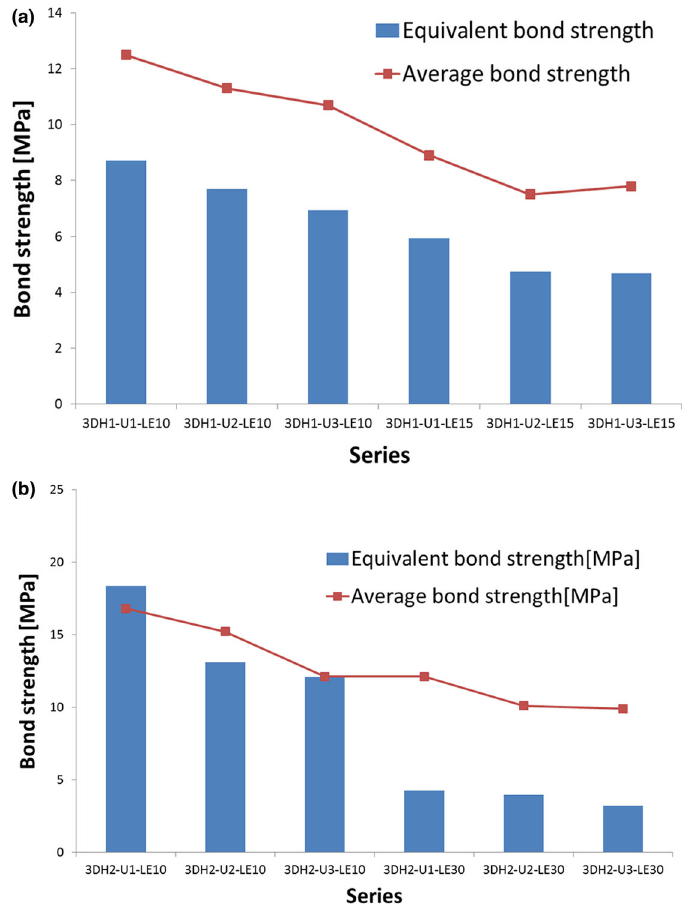
Fig. 8 Effect of W/B ratio on the bond strength of a 3DH1 fibres, b 3DH2